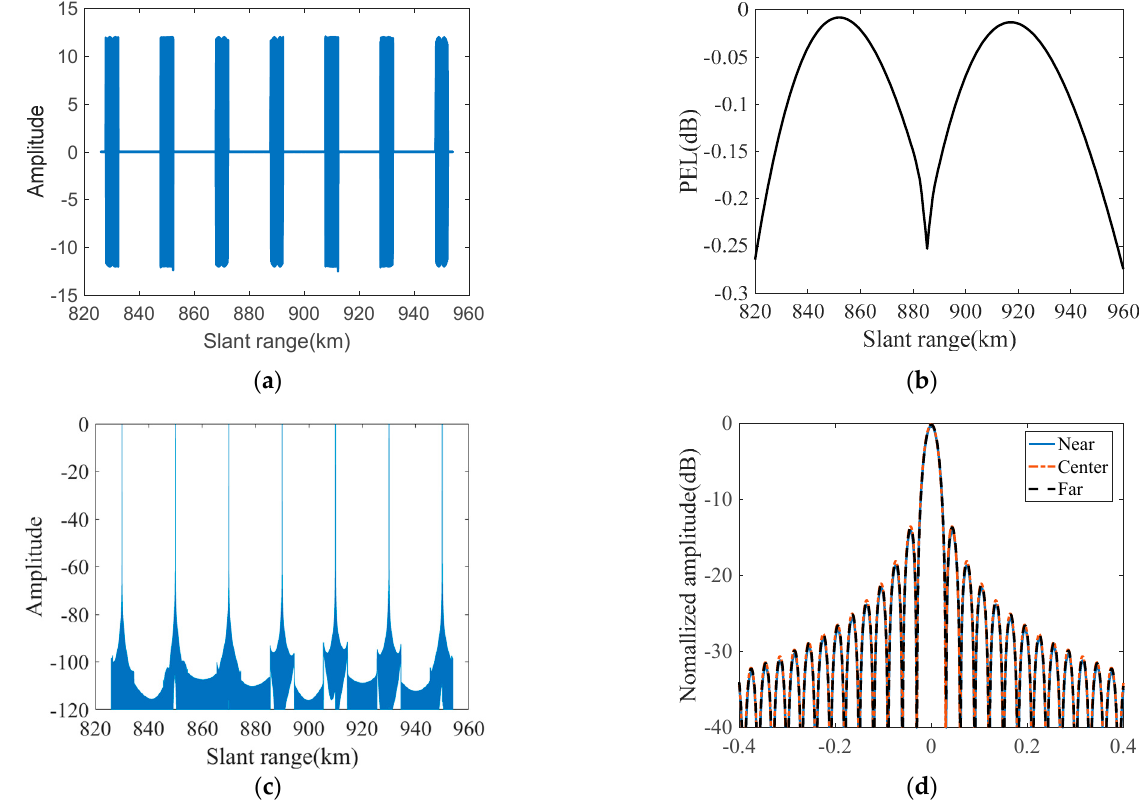
Figure 11. Processing results of the proposed DBF processor. ( a ) Real parts of the output signal handled by the proposed DBF processor. ( b ) Residual PEL. ( c ) Range compression result. ( d ) Interpolations of compression results of the selected three point targets.